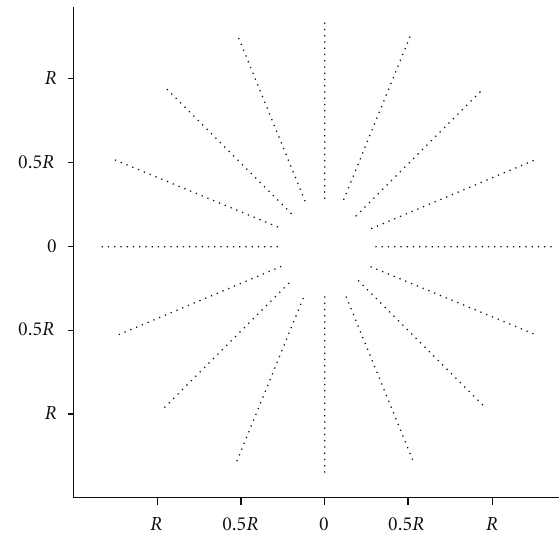
Figure 1: Exemplary distribution of locations used to transfer velocities from the viscous to the inviscid